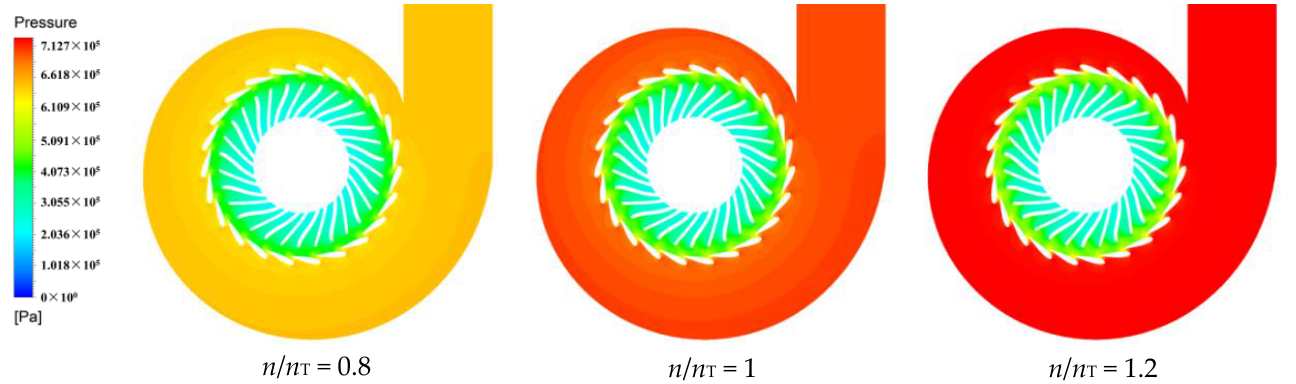
Figure 7. Pressure distributions in the turbine.